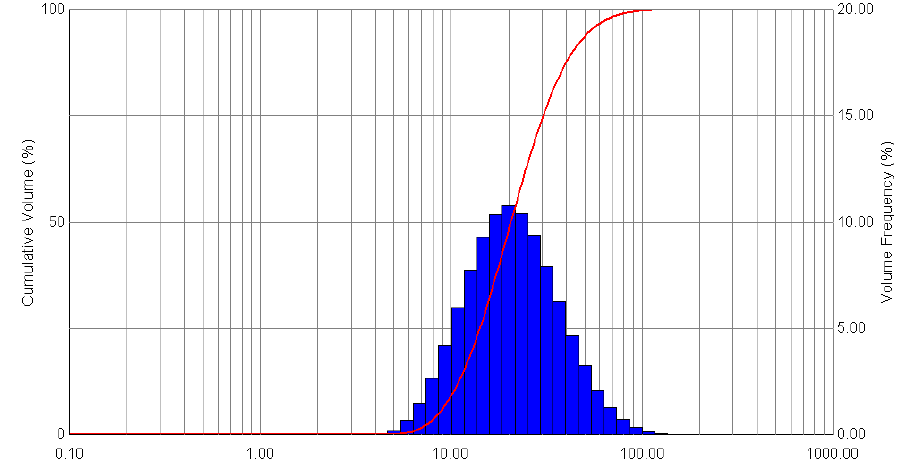
Figure 5. Particle volume distribution at 50 mm position in 800 K.